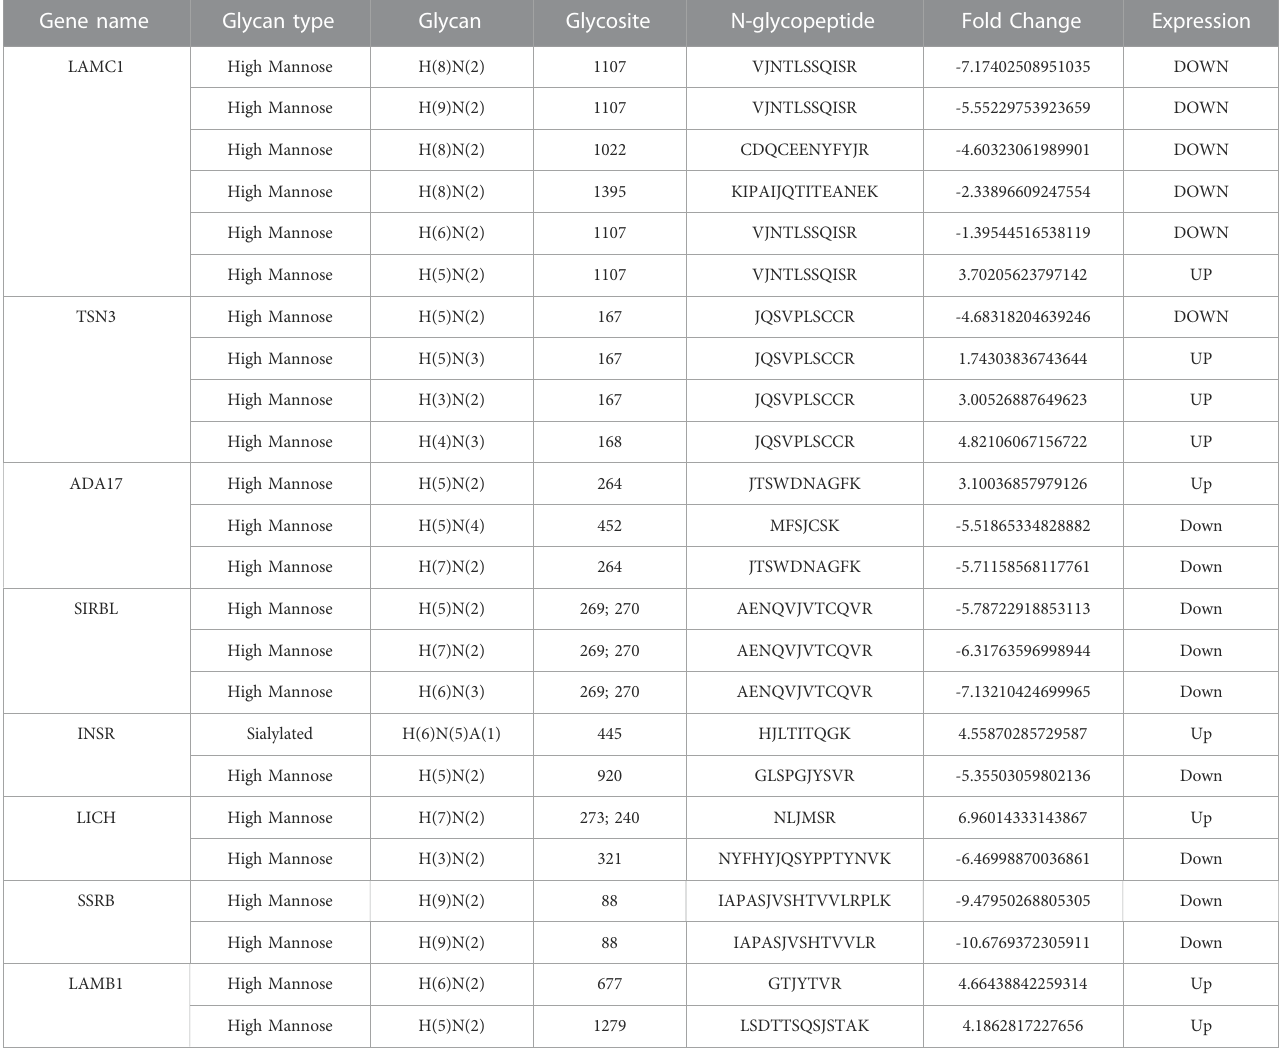
TABLE 3 DEGs of N-glycoproteins that were exclusively identi fi ed in glycoproteomics